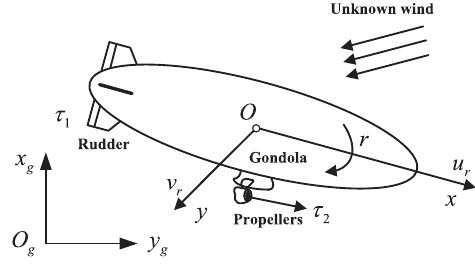
Figure 1. Structure of the stratospheric